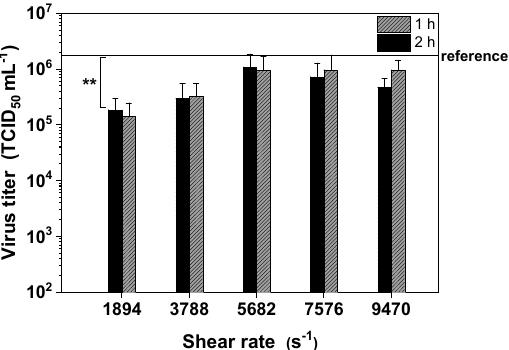
Figure 6. The time-dependent influence of shear rates in a membrane module on the infectivity of MV. The virus suspension was pumped in a circle to determine the influence of shear stress caused by the basic DSP setup with an integrated flat-sheet membrane module. Data are means plus standard deviations of triplicates. The reference is shown as a solid horizontal line (** p < 0.1).